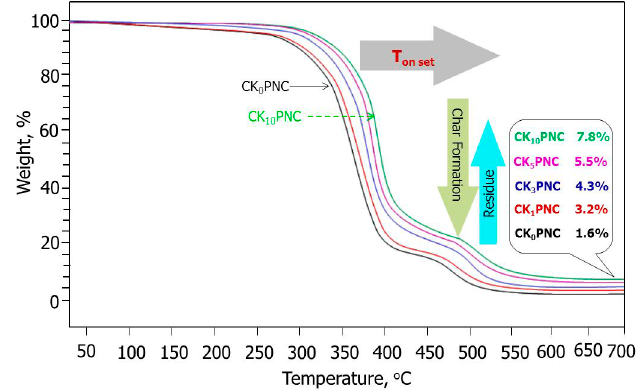
Figure 4. Thermograms of neat PMMA film and nanocomposite films.